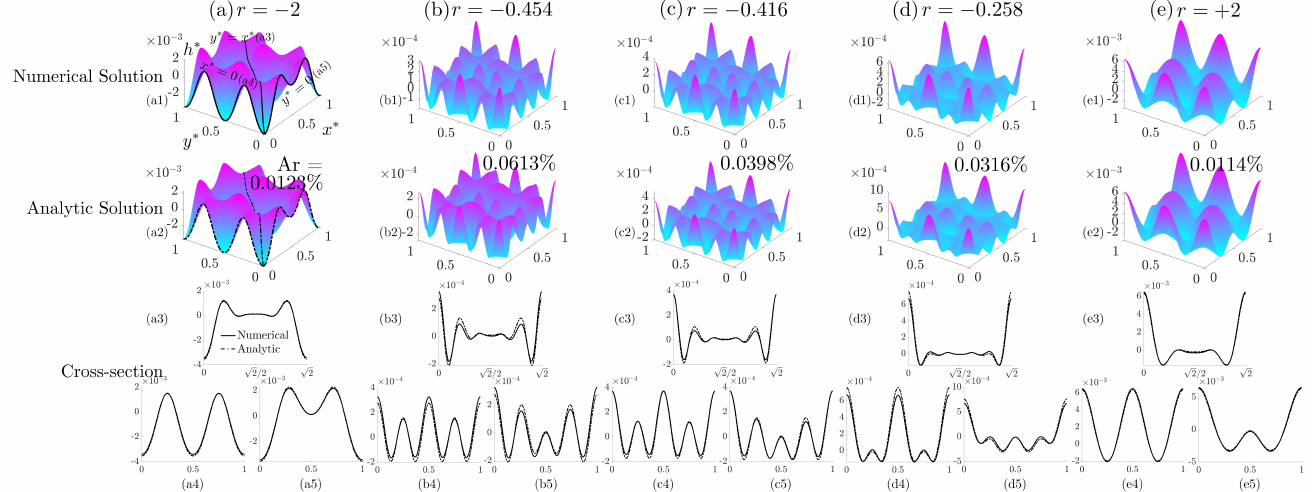
Figure 6. The numerical solution (first row, ( a1 )–( e1 )), analytic solution (second row, ( a2 )–( e2 )) and cross-section plots along a diagonal line y ∗ = x ∗ (( a3 )–( e3 )) as well as two boundaries x ∗ = 0 (( a4 )–( e4 )) and y ∗ = 0 (( a5 )–( e5 )) with r = − 2 (column ( a ), min skewness), r = − 0.454 (column ( b ), min kurtosis), r = − 0.416 (column ( c ), zero skewness), r = − 0.258 (column ( d ), max skewness) and r = + 2 (column ( e ), max kurtosis) by fixing (cid:101) 4 = − 0.01. The percentage values shown in the second row are the average difference ratio Ar defined in Equation (16). The full and dashed-line curves for the cross-sectional plots represent numerical solution and analytic solutions,